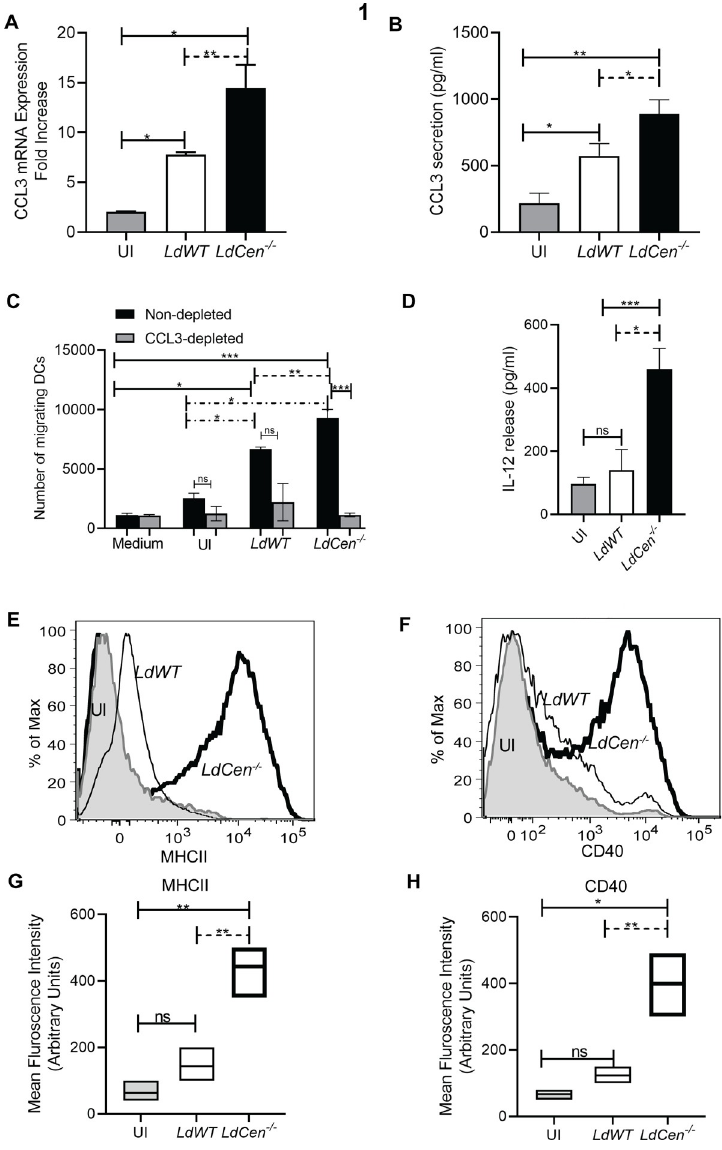
Fig 1. In presence of LdCen -/- , neutrophils produce increased CCL3 which chemo-attracts higher bone marrow- derived DCs compared to LdWT infection in vitro . (A) Peritoneal neutrophils were either left uninfected or infected with LdWT/LdCen -/- parasites for 16h. Changes in the mRNA expression levels of CCL3 from uninfected and infected neutrophils were determined by qPCR as described in Materials and Methods. The data represent the mean values ± SD of results from three independent experiments that all yielded similar results. (B) 24 hours after infection, the levels of CCL3 in the culture supernatant were evaluated by sandwich ELISA as described in Materials and Methods. ELISA data are expressed as means ± SD of values from triplicate experiments that yielded similar results. � p < 0.05; �� , p < 0.005. (C) Absolute number of dendritic cells that migrated after stimulation with supernatants from uninfected peritoneal neutrophils or neutrophils cultured in presence of LdWT or LdCen -/- infection under CCL3 non- depleted or depleted condition was measured by chemotaxis assay. The data represent the mean values ± SD of results from three independent experiments that all yielded similar results. � p < 0.05, �� p < 0.005, ��� p < 0.0005 between the groups. (D) BMDCs were cocultured with either LPS treated uninfected or infected neutrophils as described in Materials and Methods. Culture supernatants were collected to determine the IL-12 release by ELISA. The data represent the mean values ± SD of results from 3 independent experiments that all yielded similar results. � p < 0.05; ��� p < 0.0005 between the groups. (E, F) Layouts and (G, H) Mean fluorescence intensity (MFI) of MHCII and CD40 in uninfected and LdWT or LdCen -/- infected neutrophil-BMDC coculture. The data represent the mean values ± SD of results from 3 independent experiments that all yielded similar results. � p < 0.05; �� p < 0.005 between the